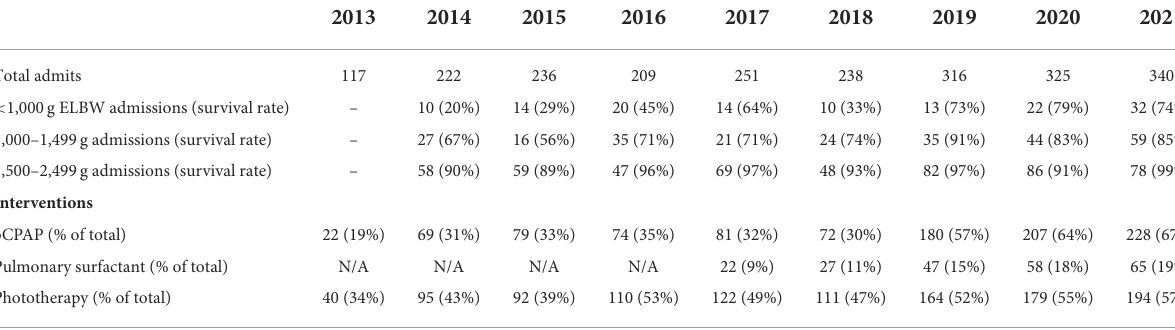
TABLE 2 NICU admission and survival rates by birthweight categories and interventions by year